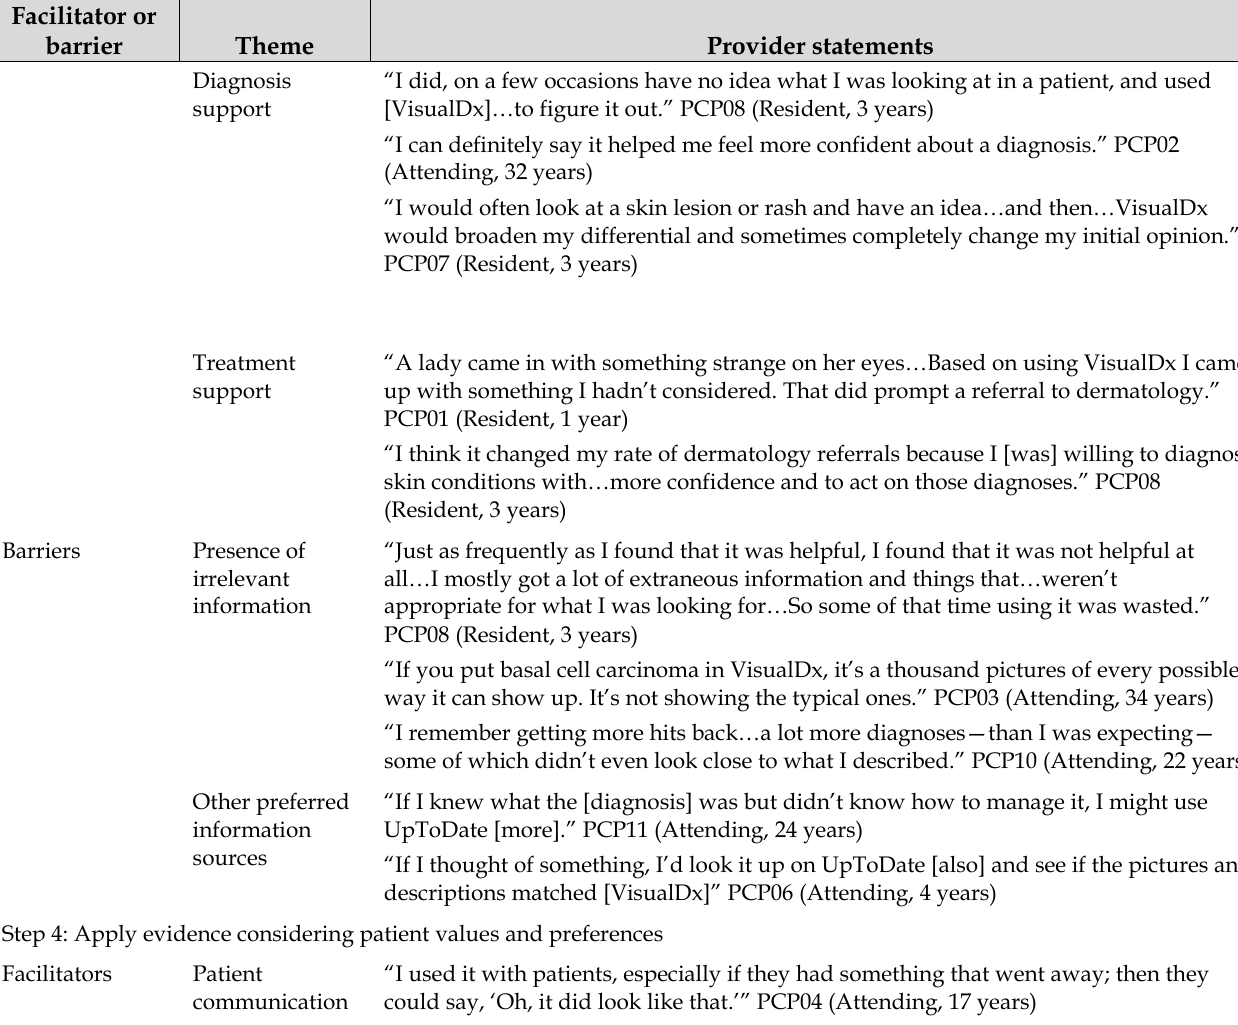
Table 3 Representative PCP statements related to facilitators and barriers to CET use aligned with behavioral EBM steps